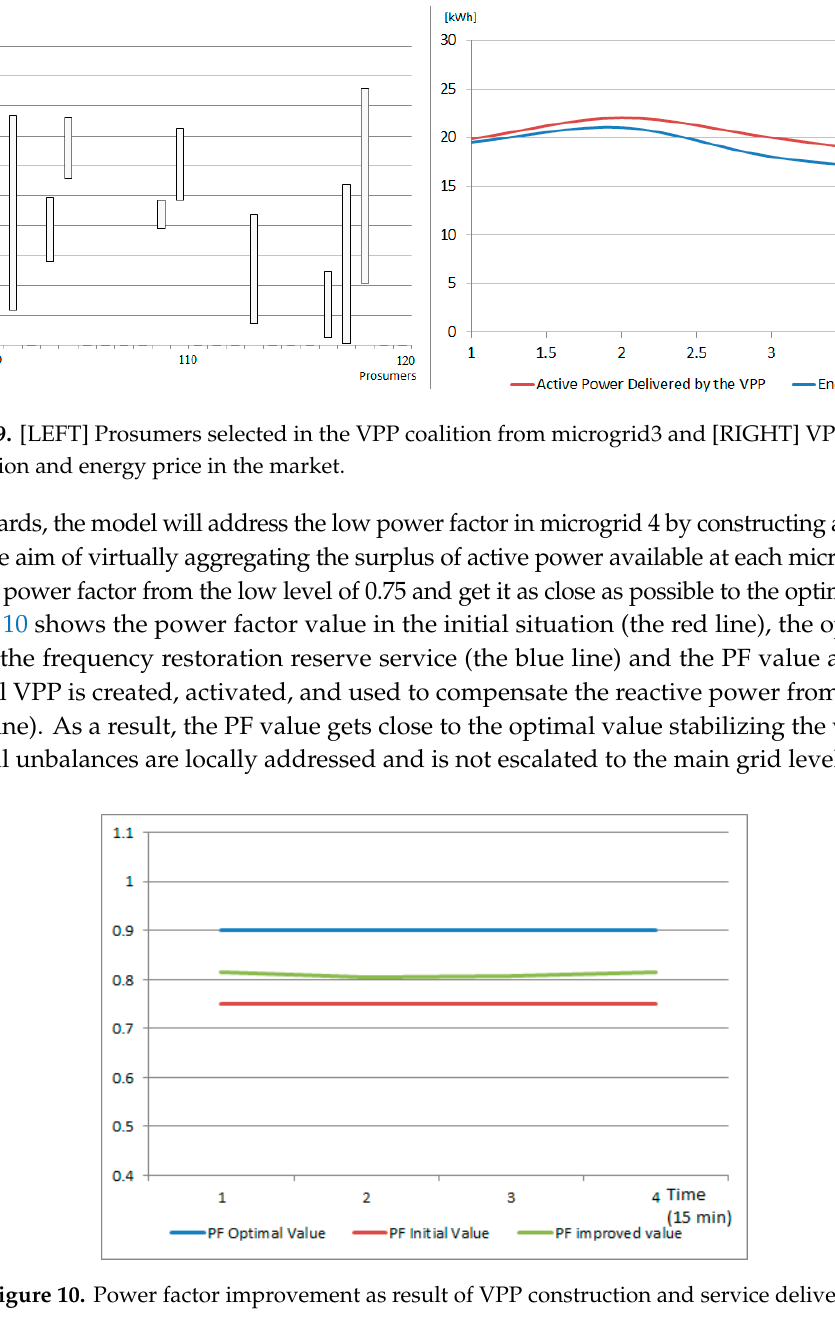
Figure 11. VPPs in the new created hierarchical VPP: [LEFT] maximum and minimum energy consumption in the service interval and [RIGHT] detailed energy profiles. The active power profiles of level one VPP2 and VPP3 (see Figure 6) consisting of 16 prosumers activated from the micro ‐ grids that create the higher level VPP4 to compensate for the low PF of microgrid 4 are shown in Figure 11. Each prosumer has a different PF value, being able to compensate together for the imbalance between the active and reactive power from the grid. The final grid situation is shown in Figure 12. It can be seen that the reactive power has been decreased by adding additional energy prosumers with a leading power factor. Furthermore, the active power in the grid has increased by around 30 kW because of the new prosumers that have been activated and grouped the VPP, whose total active power contribution is shown with the red line.